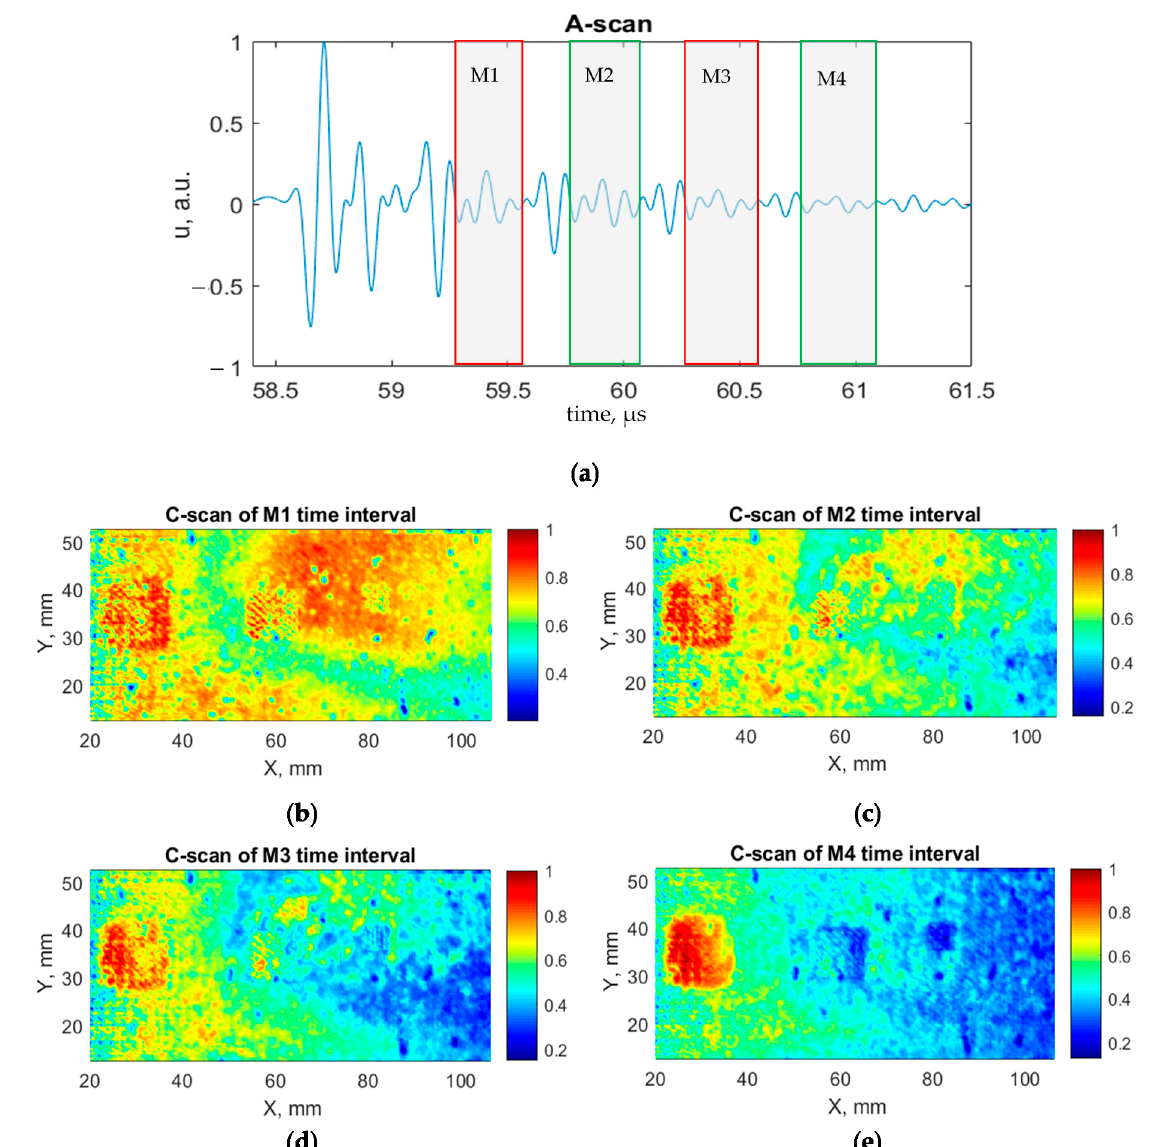
Figure 15. A-scan and C-scans: ( a ) A-scan with indicated time intervals selected to display C-scans; ( b ) C-scan of M 1 time interval; ( c ) C-scan of M 2 time interval; ( d ) C-scan of M 3 time interval; ( e ) C-scan of M 4 time interval.